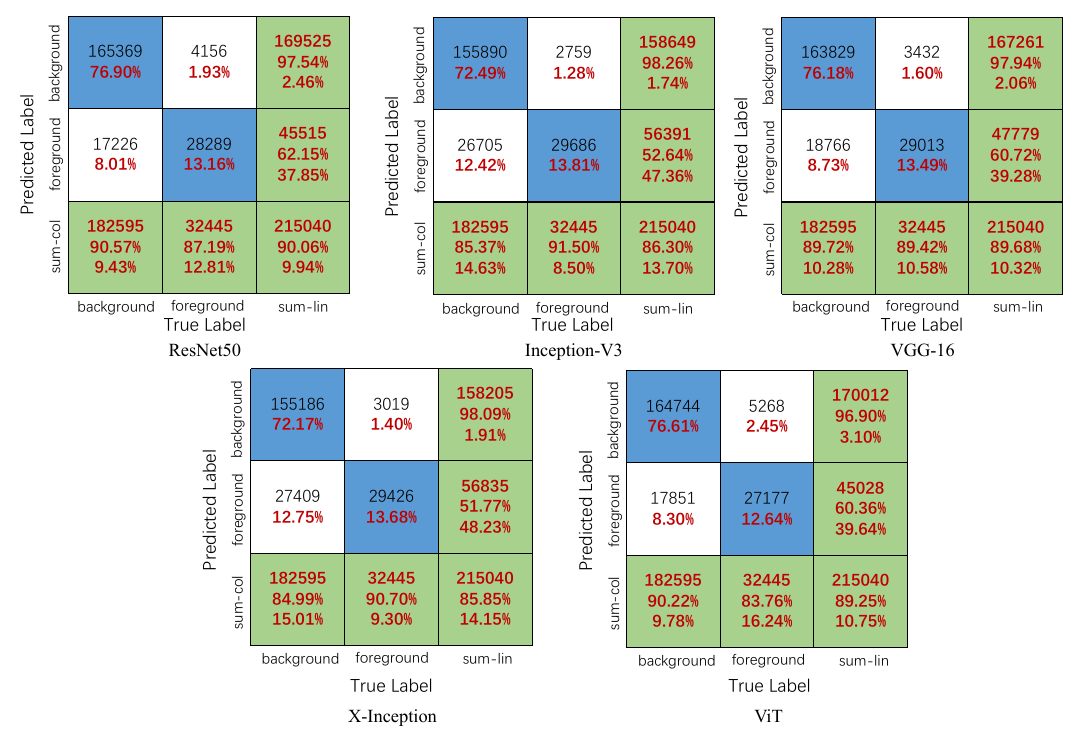
Figure 6. Predict the confusion matrix on test set of 8 × 8 pixels’ patches.